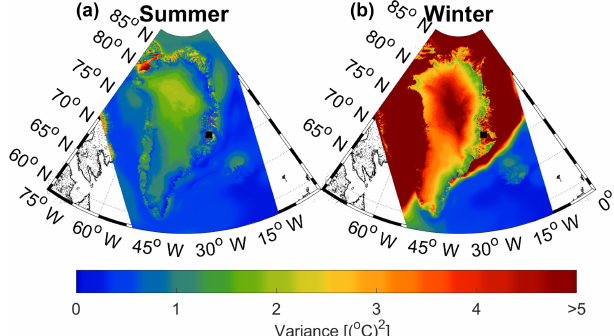
Figure 7. Variances of the summer (a) and winter-averaged tem- peratures (b) . A maximum variance of 5( ◦ C) 2 is displayed in order to emphasize the small variance in the summer-averaged